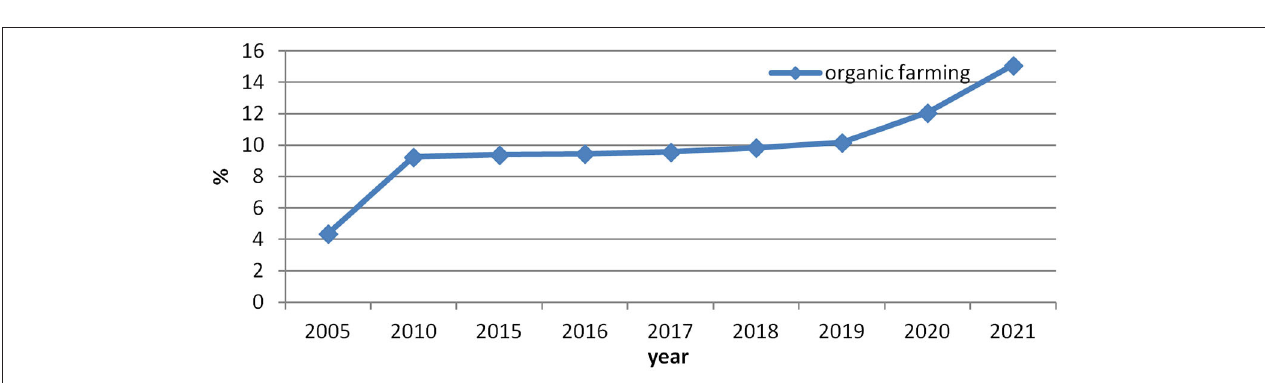
FIGURE 7 | The area registered as used for organic farming (UKSUP,